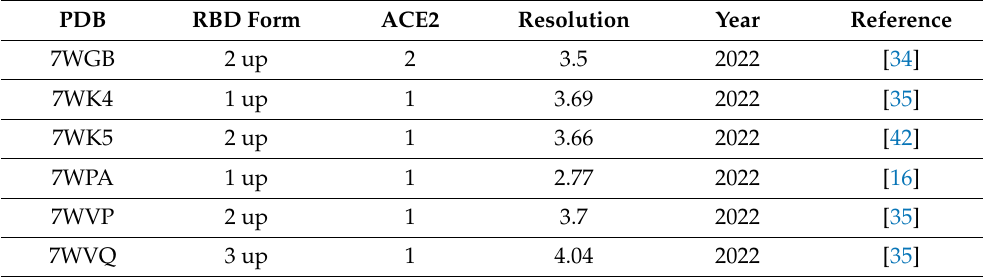
Table 2. Structures of full-length Omicron spike protein bound with